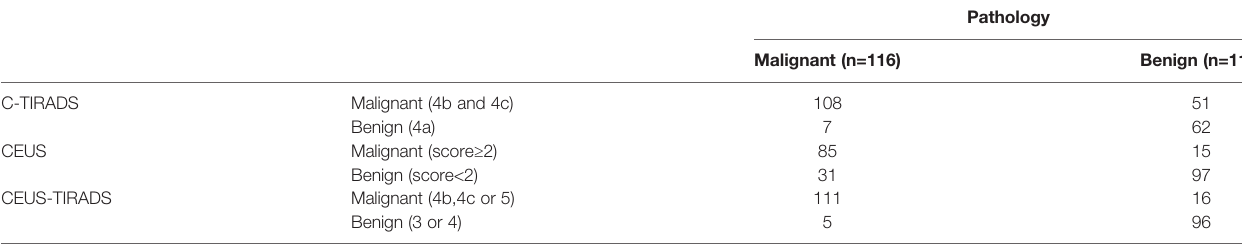
TABLE 3 | The accurate diagnosis cases of C-TIRADS, CEUS and CEUS-TIRADS diagnostic model.